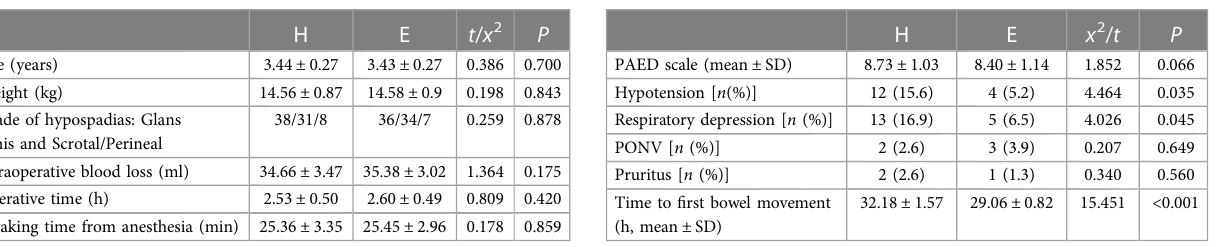
TABLE 1 Patients ’ demographic and clinical characteristics.